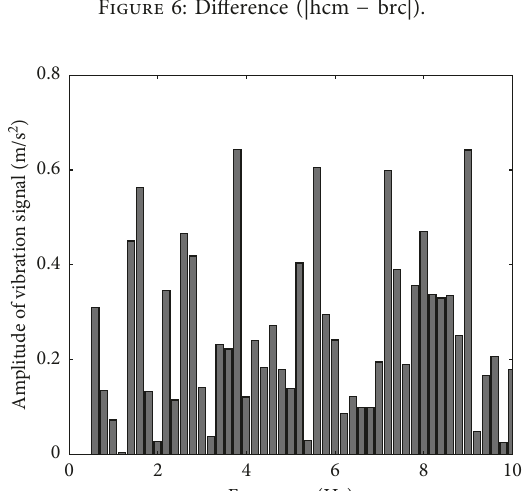
Figure 6: Difference (|hcm